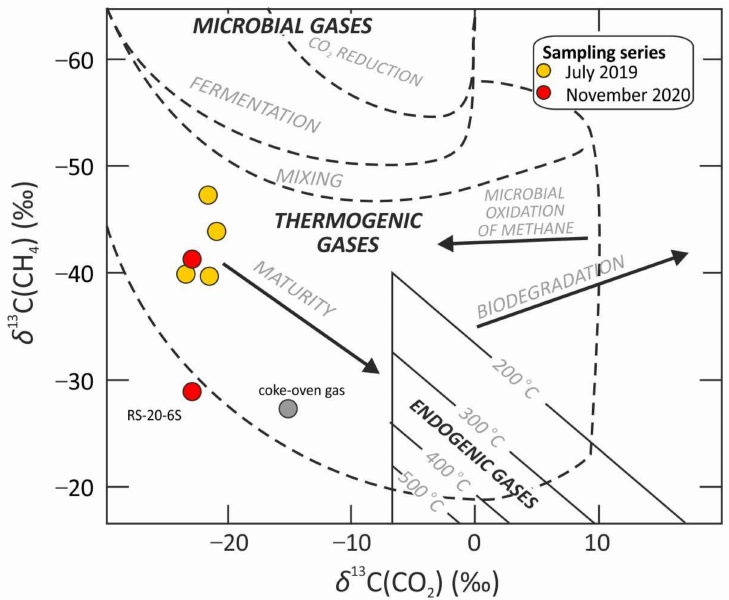
Figure 8. Genetic identification of analysed gases using δ 13 C(CH 4 ) versus δ 13 C(CO 2 ). Genetic fields modified after Gutsalo and Plotnikov [39], Milkov [40] and Kotarba